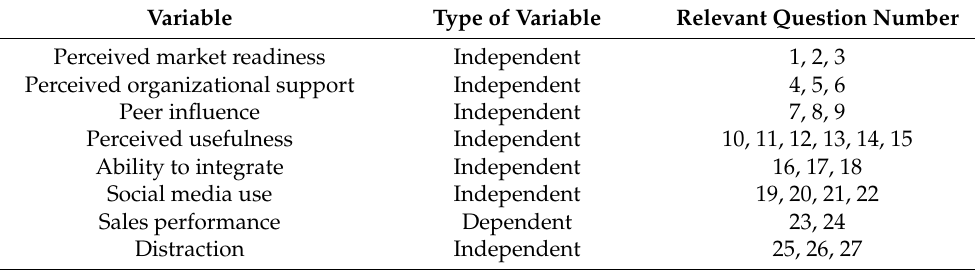
Table 2. Division of the questions according to the research